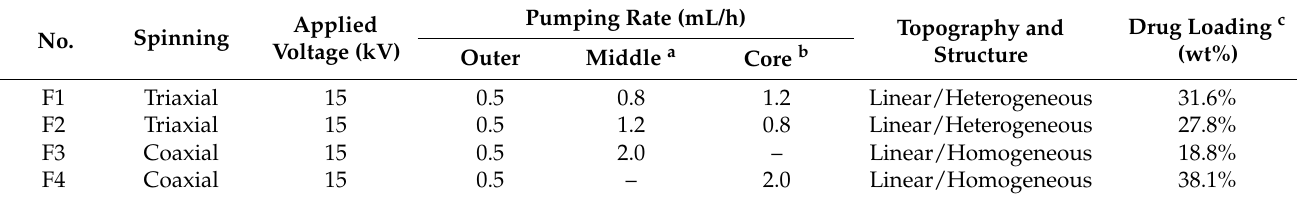
Table 1. Process parameters and theoretical drug loading of MET in the